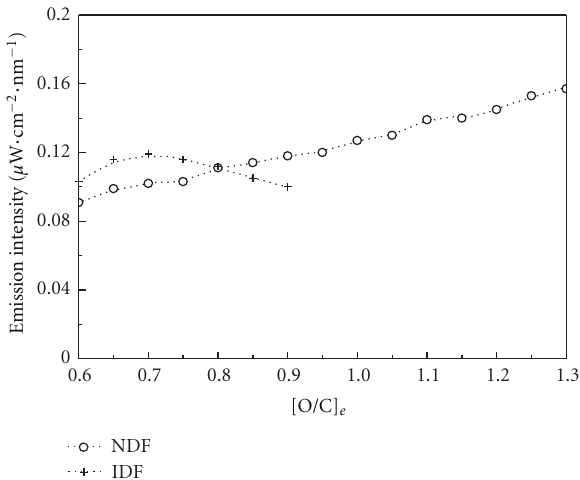
F 9: e variation of maximum OH emission with different